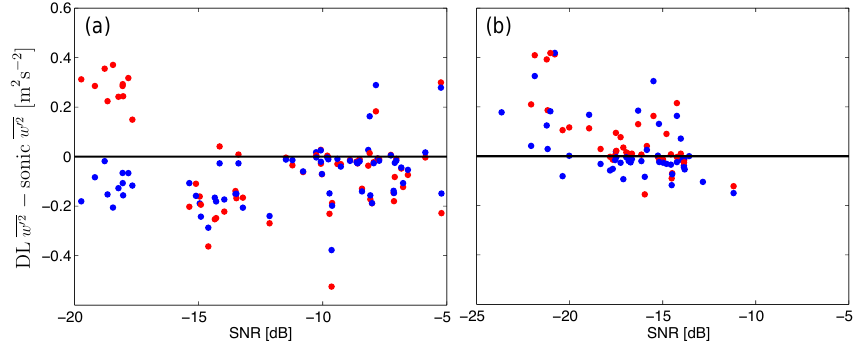
Figure 13. Relation of SNR with error of lidar measured w (cid:48) 2 compared to w (cid:48) 2 computed from sonic anemometer measurements, for raw (red) and corrected (blue) measurements. Measurements from the OU DL at 300m are shown in (a) , while LLNL WC measurements at 100m are shown in (b)